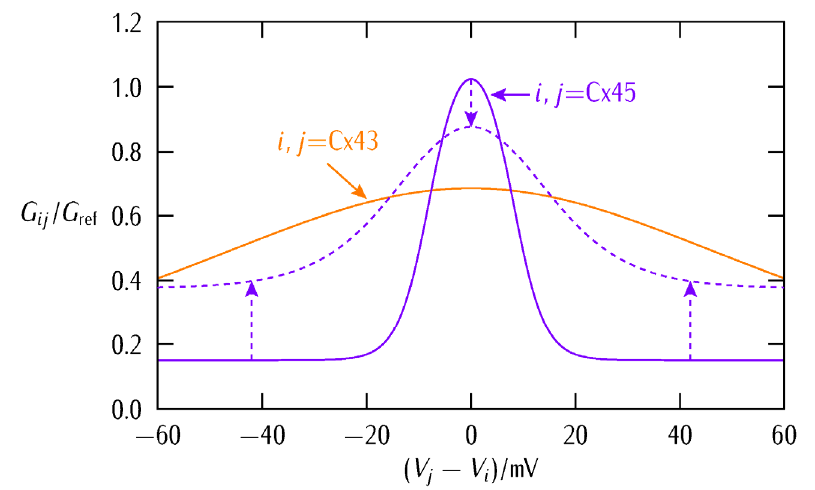
Figure 8. The Cx45 junction voltage-gated conductance tends to the Cx43 one by increasing the minimum conductance term G 1 and V 0, j = V 0, j = V 0 in Equation (3), as shown qualitatively by the arrows and the dashed curve. This transition gives an enhanced connectivity which is almost independent of the intercellular potential difference in the case of the Cx43 junction, contrary to the case of the original sharp Cx45 junction; see Figure 1 here for the experimental conductances together with [21]. This result may suggest new opportunities for bioelectrical normalization if the patch junction conductance can be modulated independently of the surrounding bulk junction conductance. In particular, the patch conductance should be increased at the initial stages of abnormal depolarization to assist the normalization forced by the surrounding bulk while it should be decreased at late stages of patch growing and consolidation to avoid the patch resistance to normalization as a whole. Note, however, that this is a purely bioelectrical result while connexins and gap junctions have also other biochemical and biomechanical functions in addition to provide intercellular electrical conductances.